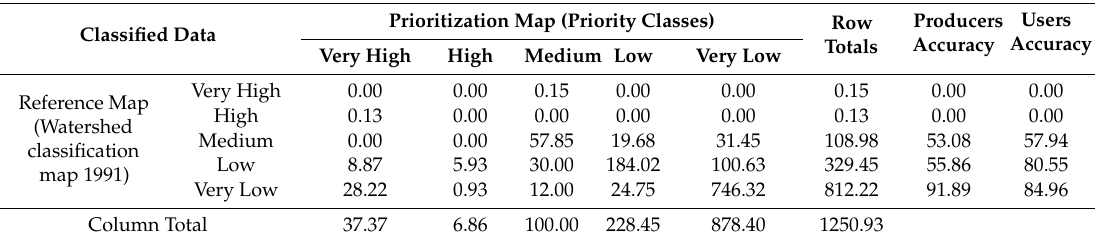
Table 8. Validation between the prioritization map and the watershed classification data derived from the Department of Water Resources in